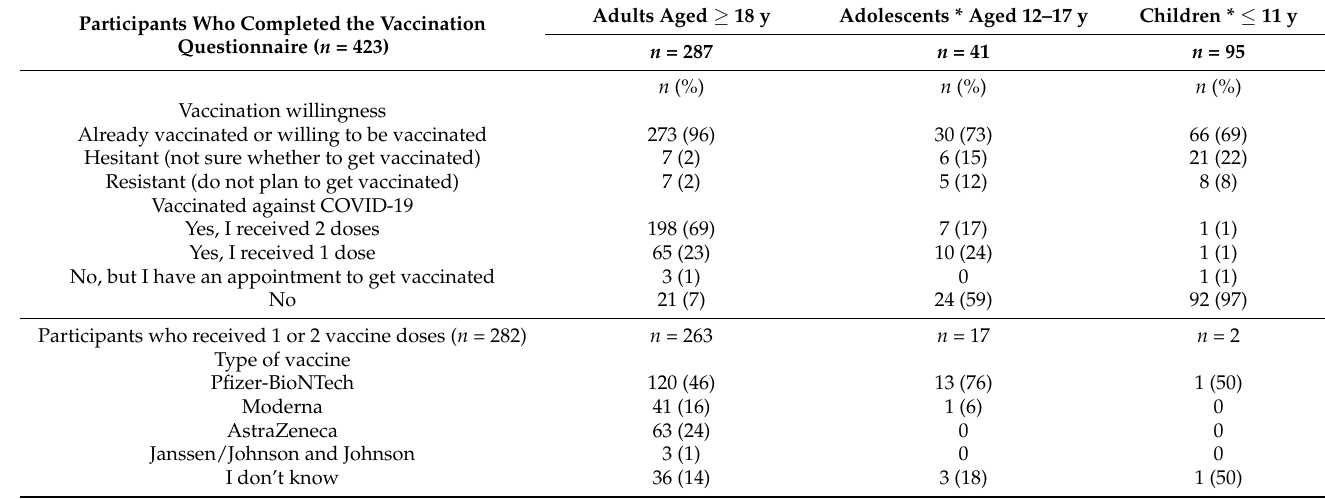
Table 1. Self-reported vaccination willingness, vaccination uptake, and vaccine type among people with primary ciliary dyskinesia by age ( n = 423) (COVID-PCD study, May 2021). Participants Who Completed the Vaccination Questionnaire ( n =